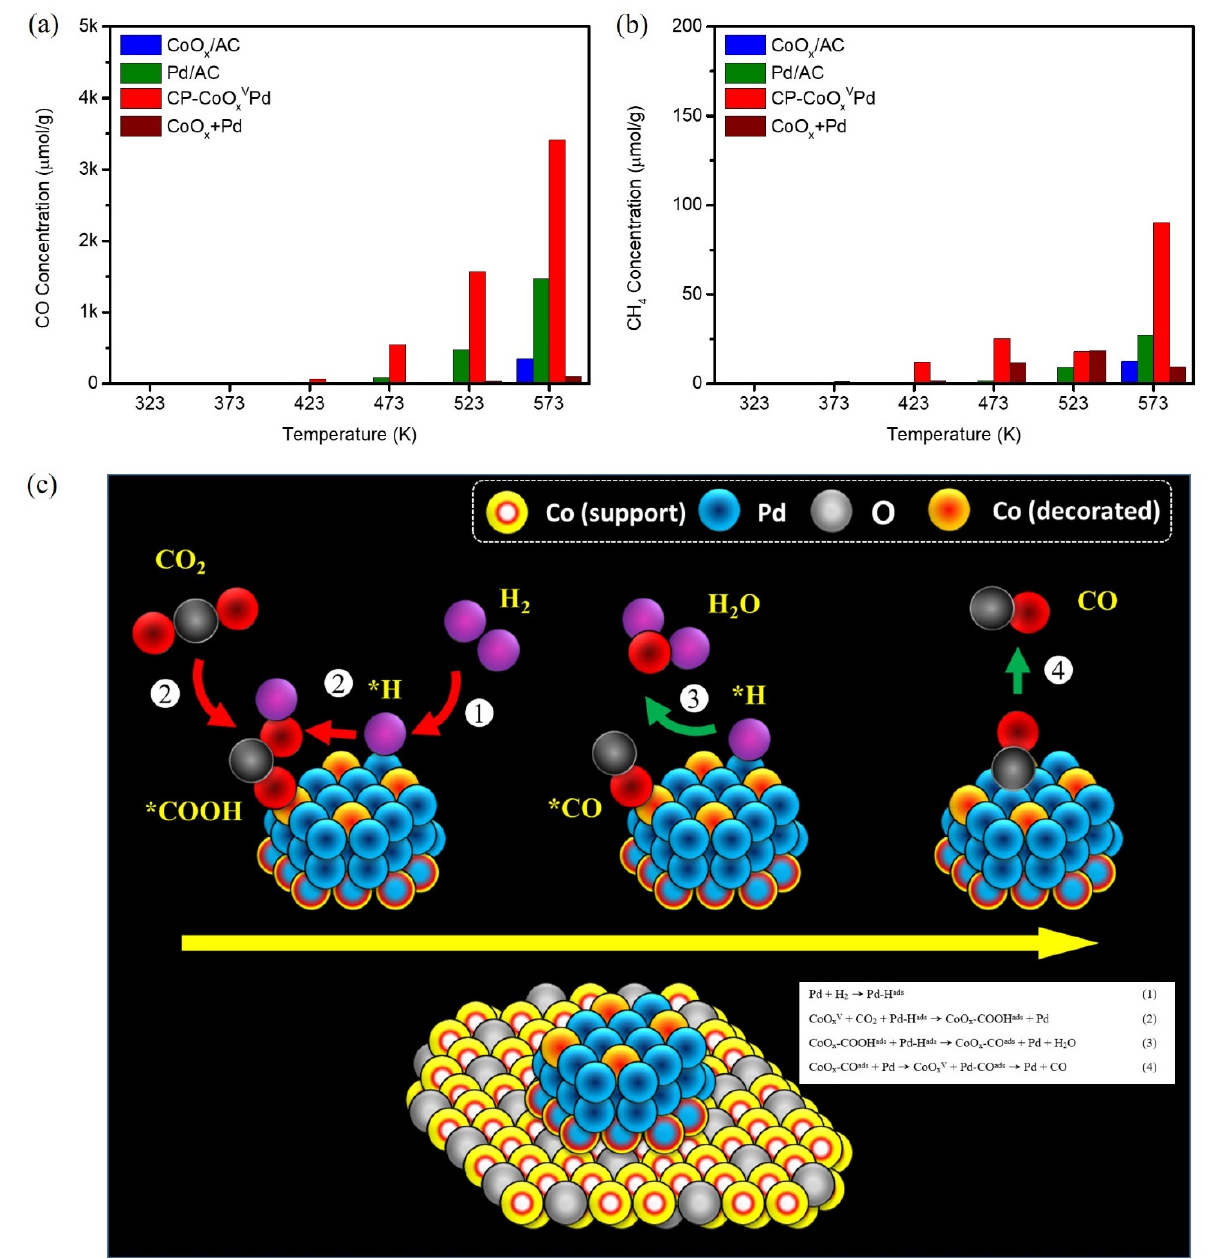
Figure 6. Gas chromatography (GC)-determined ( a ) CO and ( b ) CH 4 production yields of CP- CoO xV Pd NC compared with CoO x /AC, Pd/AC and physical mixture of CoO x /AC+Pd/AC in the ambient of CO 2 and H 2 mixture with CO 2 :H 2 ratio of 1:3. ( c ) The proposed mechanism of CO 2 hydrogenation on the CP-CoOxVPd NC.